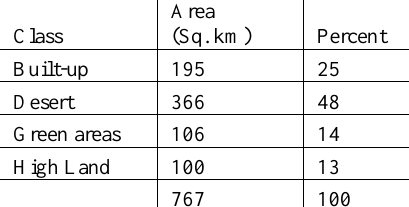
Table 2. Land Use/ Land Cover breakdown.